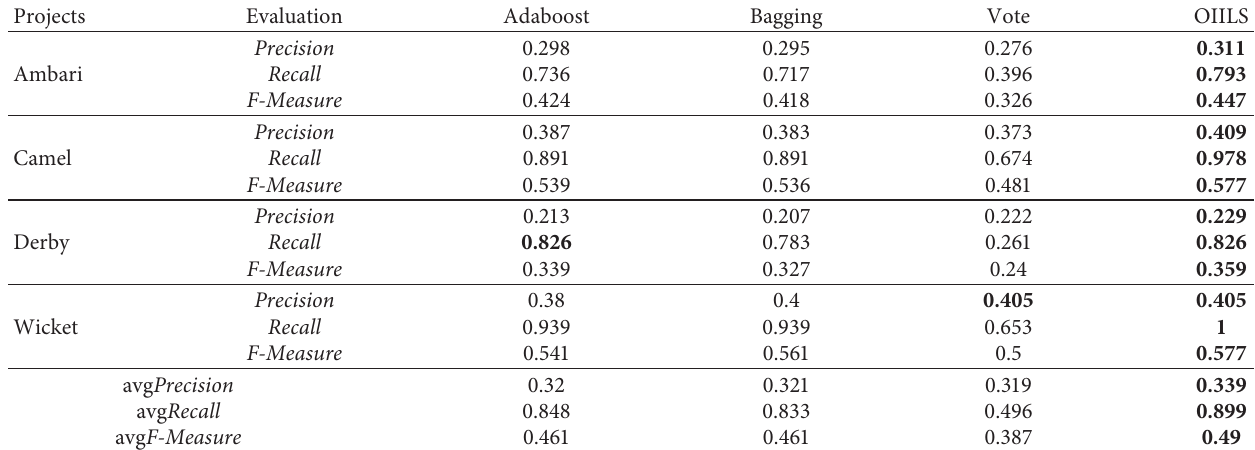
Table 8: The performance of four ensemble